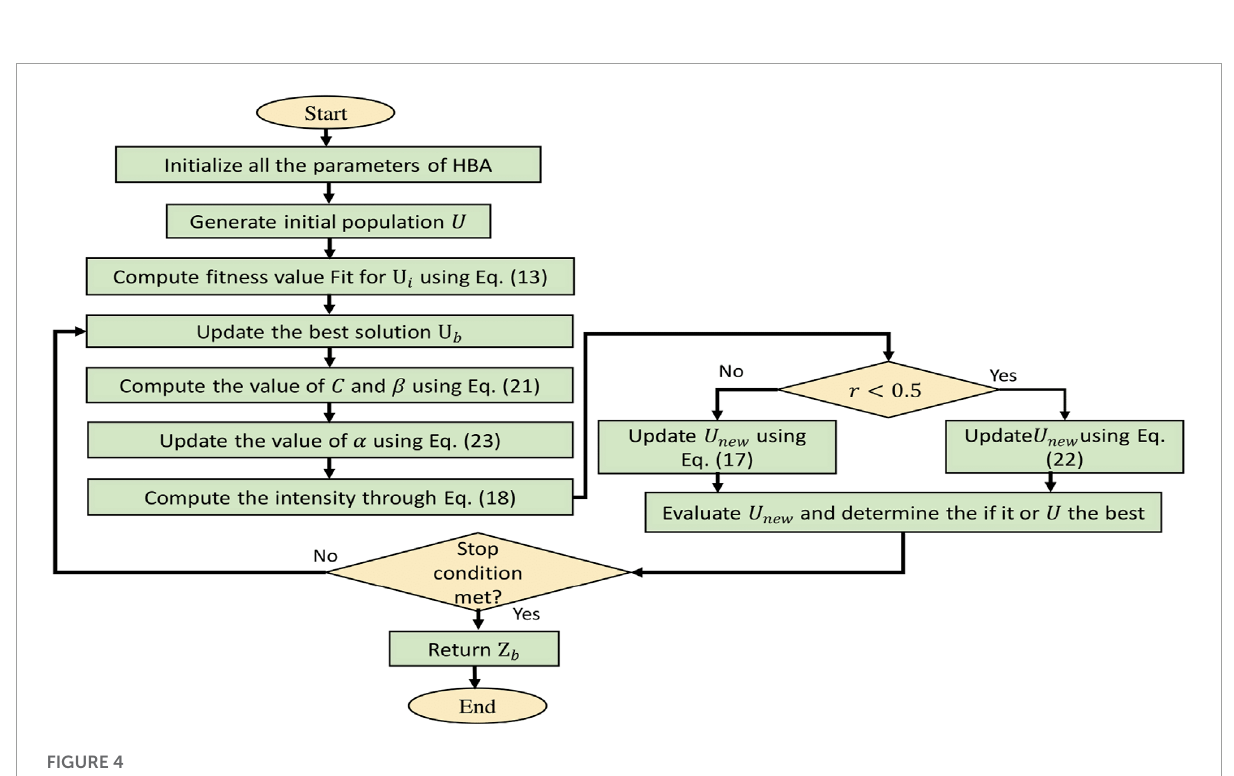
FIGURE 4 flowchart of CHBAlg